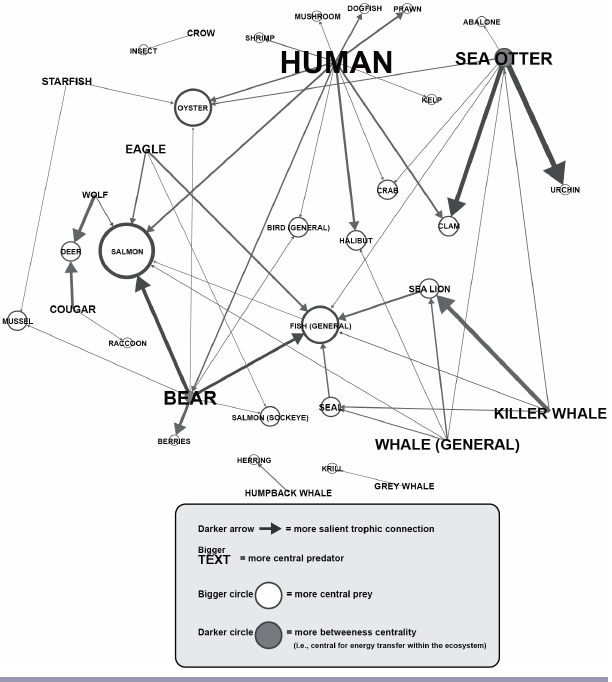
Fig. 4 . Aggregate mental model of the regional food web: females. Women’s aggregate mental model is cognitively dominated by the feeding habits of sea otters. On average, women appear especially cognizant of otters’ penchant for urchins and clams. Similarly salient for women are the feeding habits of large charismatic megafauna (bears, killer whales, cougars, and wolves). The feeding habits of humans appear to be less cognitively accessible to women than those of other mammals. Nonetheless, the prolific nature of human predation plays a uniquely central structural role in women’s aggregate mental model. In other words, while humans’ eating habits are not necessarily immediately apparent to women in the context of imagining the local food web, once humans’ role is indeed considered, it becomes highly central to women’s mental representation of the system. Central prey species in women’s mental representations of the food web include salmon, oysters, and fish (the latter as a broad, but commonly cited, taxonomic category). Women also appear aware of several other parallel features of the food web, such as the importance of herring and krill to baleen whales. These subsystems nonetheless remain conceptually detached from the web as a whole. (Note that this visualization is demonstrative of the method’s potential uses, not necessarily representative of a demographic with statistically distinct responses).